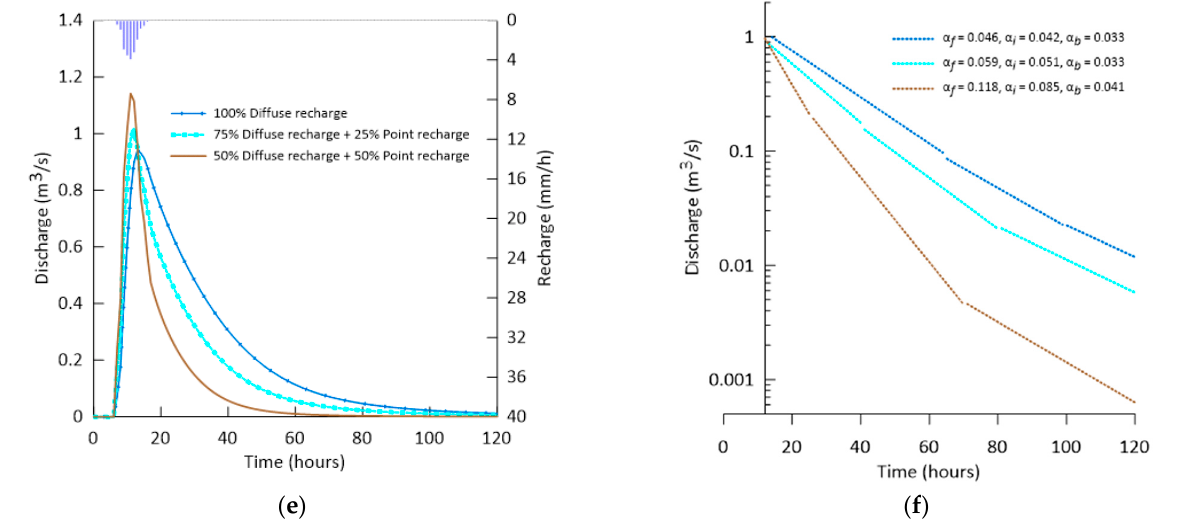
Figure 16. ( a , c , e ) The spring hydrographs were obtained from curvilinear branchwork, rectilinear branchwork, and network maze patterns under different recharge types (scenario C). ( b , d , f ) Recession curves ( α f , α i , and α b are the fast flow, intermediate flow, and baseflow recession coefficients, respectively). The blue lines at top of graphs indicate recharge.